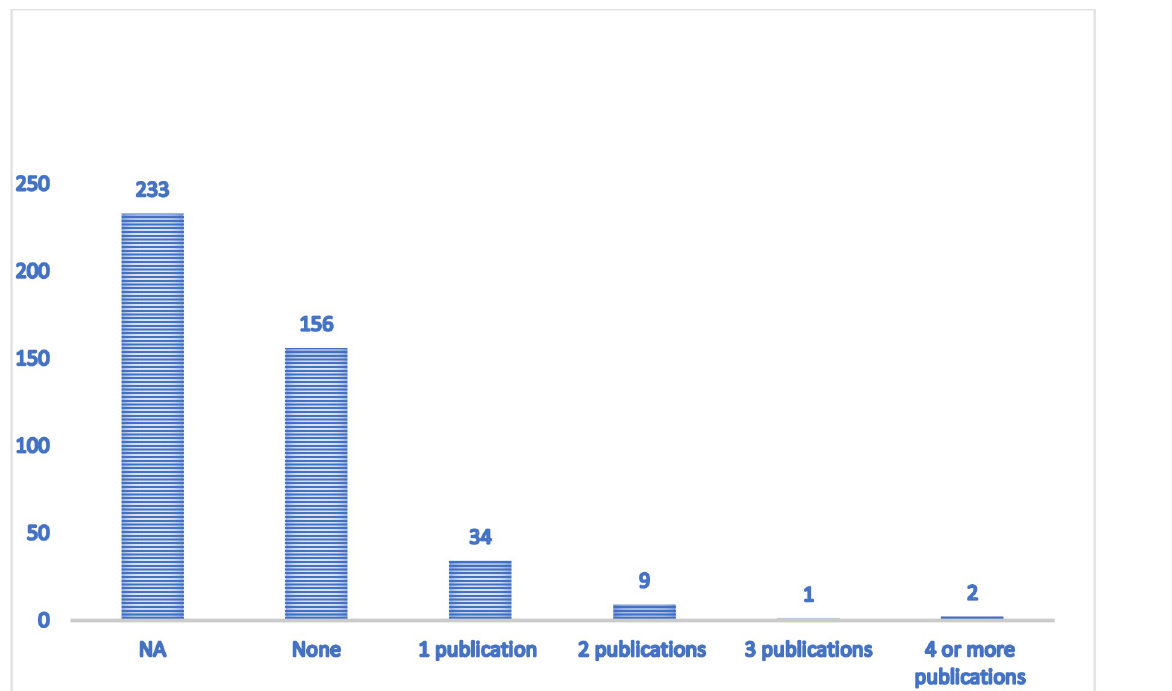
Fig 4. Number of publications by